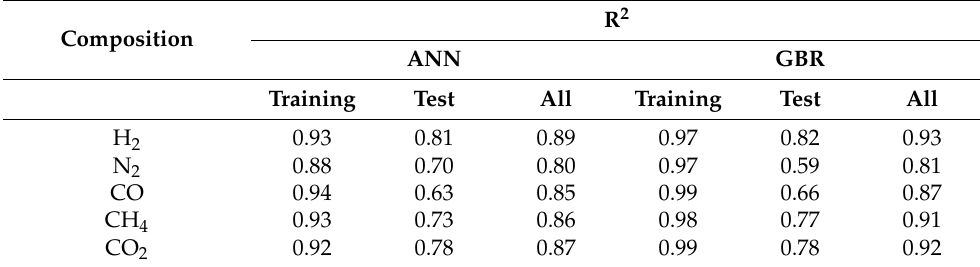
Table 6. Statistics of the performance of the ANN and GBR models.